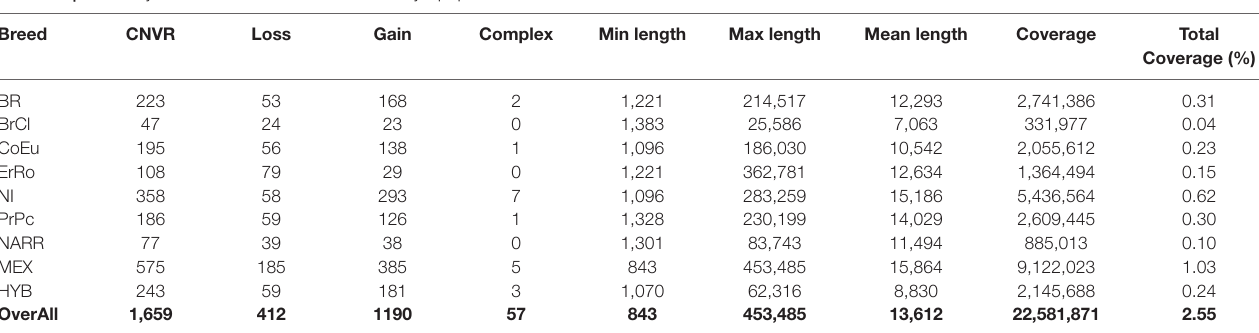
Among the 362 CNVRs a total of 140 were mapped only in one specific population, the breed_CNVRs, as reported in Supplementary Table 4 . The mapped genes in any species and the corresponding references for each association studies, the associated phenotypes and the organism involved, are also indicated.